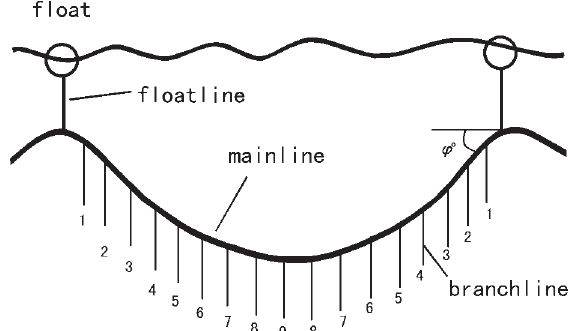
Fig . 2. – Configuration of unit basket of longline gear similar to the longline used by the Chinese tuna fishery in the central-eastern Pacific Ocean. The number in the illustration indicates the hook number, i.e. there are 17 hooks here in the unit Fig . 1. – Set positions of the fishing trip for the Chinese longline fishery in the central-eastern Pacific Ocean in February-November 2006. Species sampled in these sets: BET (941), YFT (291), ALB (196), SKJ (32), SWO (70), BUM (35), BSH (118), BTH (55), SSQ (33), PSK (49), PLS (70), ALX (70), TAL (94), TST (37), LEC (115), NEN (64), WAH (73). See Table 1 for full species names. The number indicates sample size.